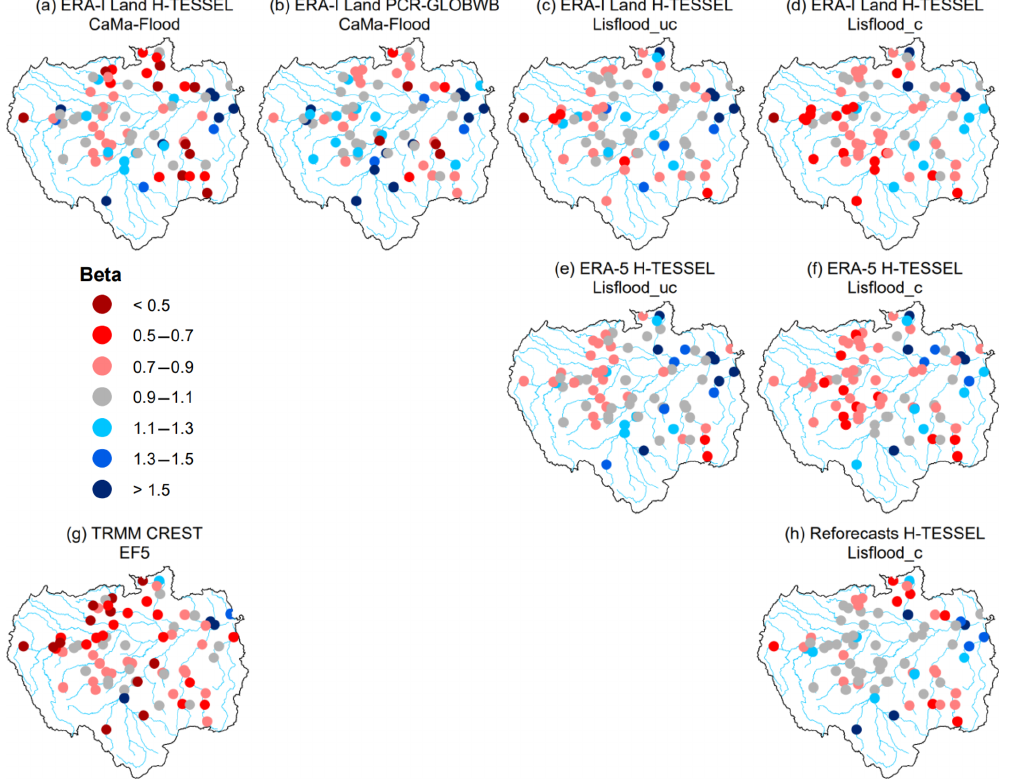
Figure 5. Beta (i.e. bias ratio) component of the KGE at the 75 hydrological gauging stations for all the simulations. For the periods 1997– 2015 and 2004–2015 for the Coupled Routing and Excess Storage, Ensemble Framework for Flash Flood Forecasting (CREST EF5) run (g). Blue circles indicate that the bias in the simulated time series is higher than that of the observed one, while red circles show the opposite effect. Values closer to one indicate better model performance (i.e. grey